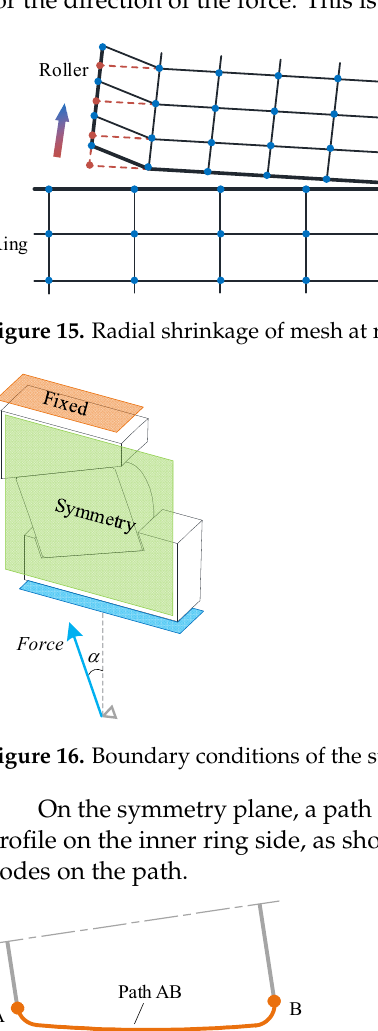
Figure 15. Radial shrinkage of mesh at roller edge.